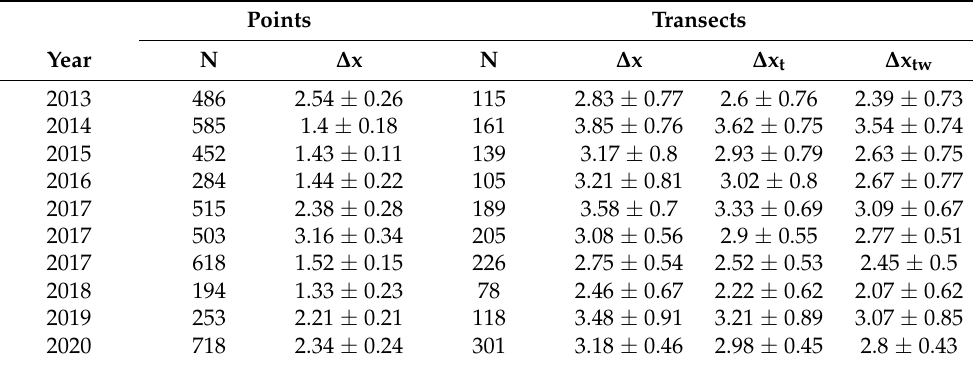
Table 4. Mean difference between Global Positioning System shorelines (GPSS) and WorldView- derived shorelines (WVS) ( ∆ x) by year using both a point and transect-based method. Transect data were corrected for differences between collection date ( ∆ x t ) and water level ( ∆ x tw ). N is the number of points or transects for each satellite image date.